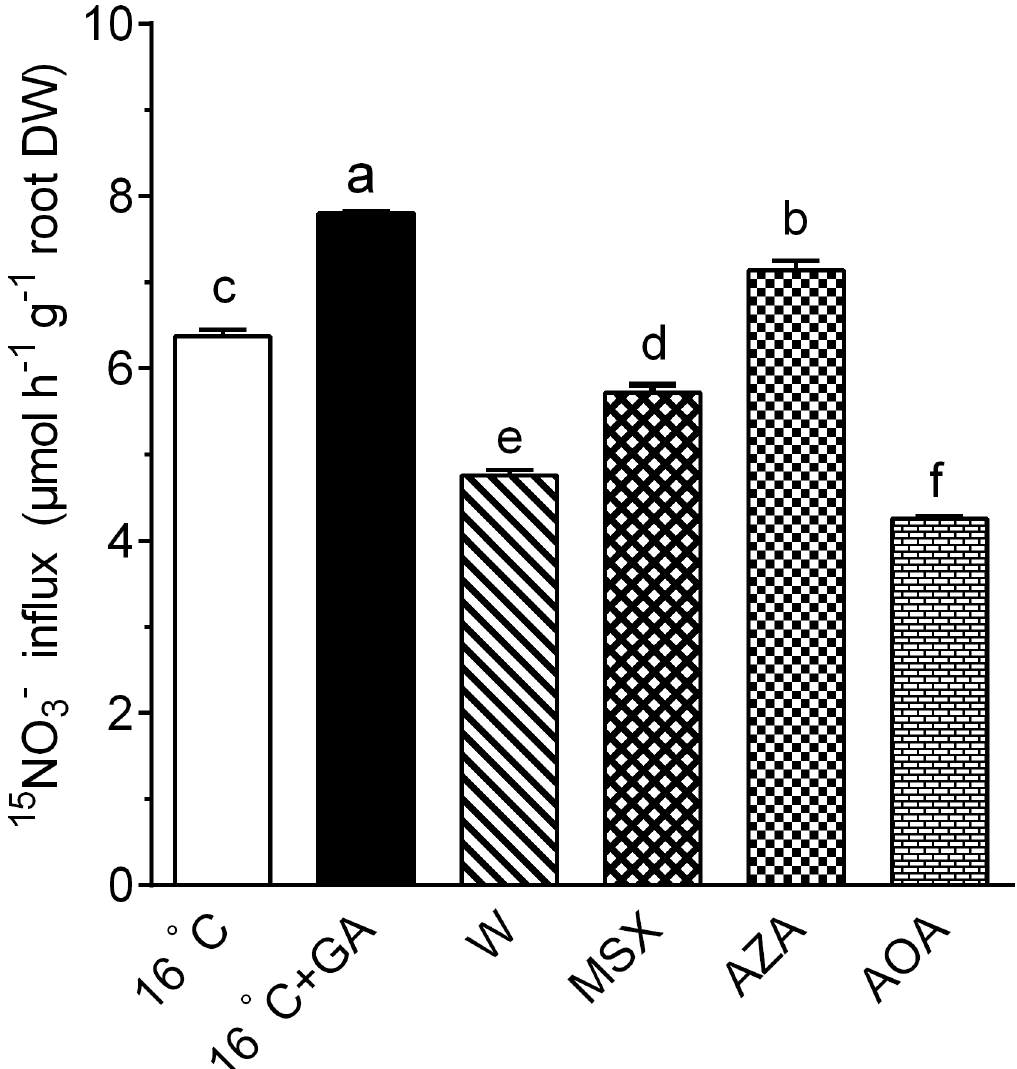
Fig 6. Effects of inhibitors of key enzymes in N assimilation on 15 NO 3- influx of cucumber seedlings. 20-day- old cucumber seedlings were exposed for 6 h to 16°C T r (16°C), 16°C T r in the presence of 5 μ M GA (16°C+GA), 5 μ M GA plus 0.5 mM tungstate (W), 5 μ M GA plus 0.25 mM L-methionine sulphoximine (MSX), 5 μ M GA plus 0.5 mM azaserine (AZA), and 5 μ M GA plus 1 mM aminooxyacetate (AOA). Data are means ± SE. Different letters on the top of column indicate significant differences ( P < 0 . 05 , n =